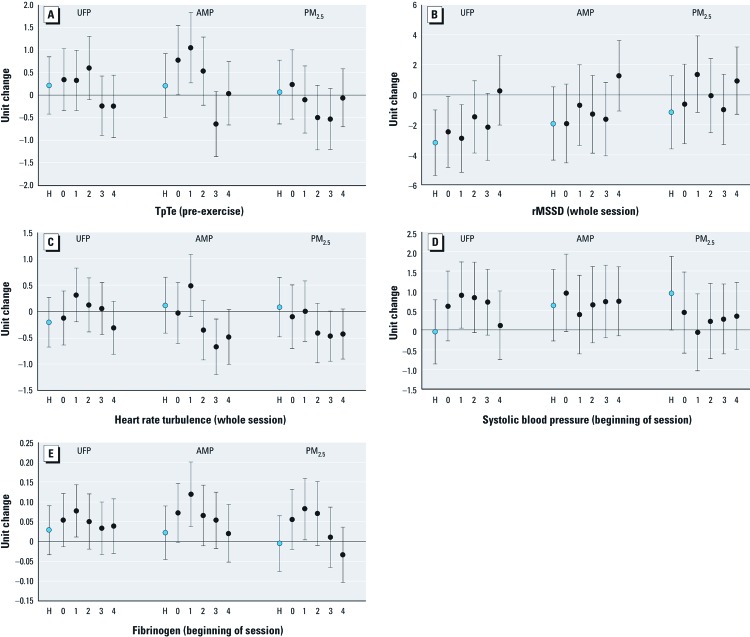
Unit change in TpTe measured at the beginning of the exercise session (A), rMSSD (B), and HRT measured across the whole session (C), and systolic blood pressure (D) and fibrinogen measured at the beginning of the exercise session (E), each with its 95% CI, associated with each IQR increase in UFP (10–100 nm), AMP (100–500 nm), and PM2.5 concentration, by lag hours. H, 6-hr mean, which is indicated by the blue circle (lag hr 0–5); 0, lag 0 (lag hr 0–23); 1, lag 1 (lag hr 24–47); 2, lag 2 (lag hr 48–71); 3, lag 3 (lag hr 72–95); 4, lag 4 (lag hr 96–119).